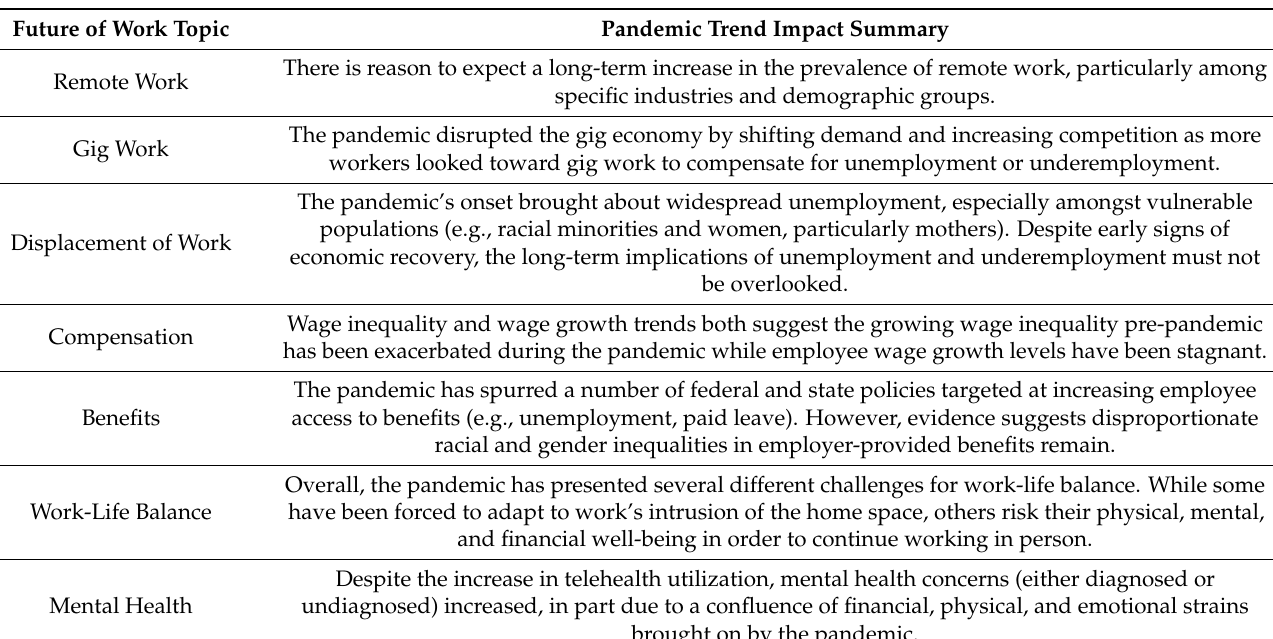
Table 1. Summary of the pandemic’s impact on the future of work topics. Future of Work Topic Pandemic Trend Impact